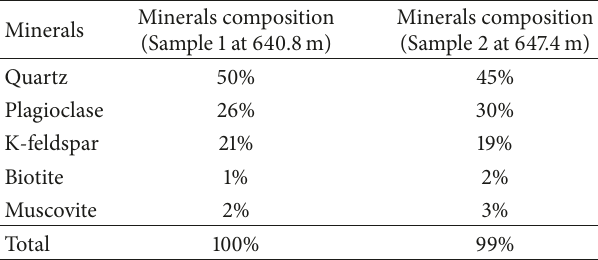
Table 1: Hydrologic parameters, initial, and injection/production boundary conditions used for 3D simulations of a 5-spot well pattern.